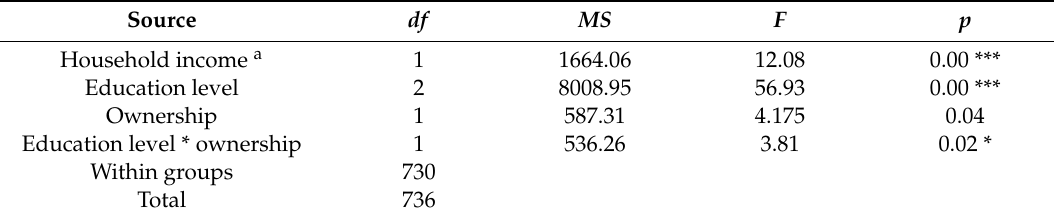
Table 7. ANOVA of impact of ownership and education level on BNS-R.